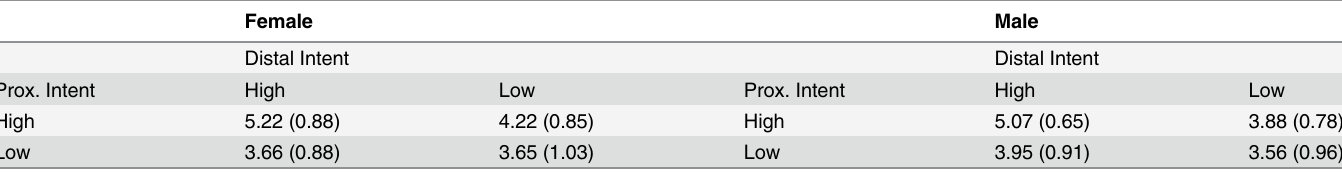
Table 5. Praise of the actor. (Standard deviations in parentheses.)